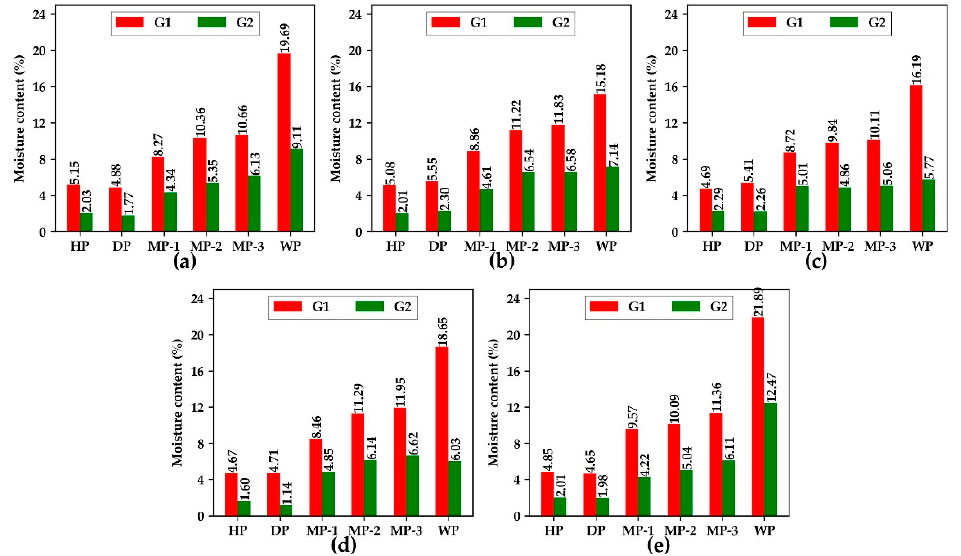
Figure 3. Moisture content of different varieties of peanut. ( a ) BLACK, ( b ) DBS, ( c ) QC, ( d ) SLH, ( e ) XBS. HP, healthy peanuts; DP, damaged peanuts; MP-(1-3), moldy peanuts in three periods; WP, white moldy peanuts; G1, the first moisture content gradient; G2, the second moisture content gra- dient.